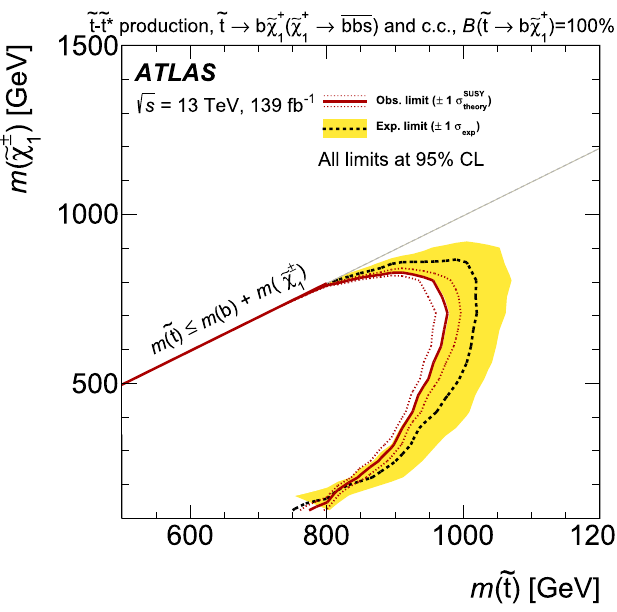
Fig. 7 Observed and expected exclusion contours for the ˜ t and χ ± The dotted lines around the observed limit illustrate the change in the 1 observedlimitasthenominalsignalcross-sectionisscaledupanddown masses in a top-squark production model with RPV decays of the χ ± . 1 by the theoretical uncertainty. All limits are computed at 95% CL. The ) equal to unity. The contours of Limits are shown for B ( ˜ t → b χ + 1 results are constrained by the kinematic limits of the top-squark decay the band around the expected limit are the ± 1 σ variations, including all into a chargino and a bottom quark (diagonal line) uncertaintiesexcepttheoreticaluncertaintiesinthesignalcross-section.